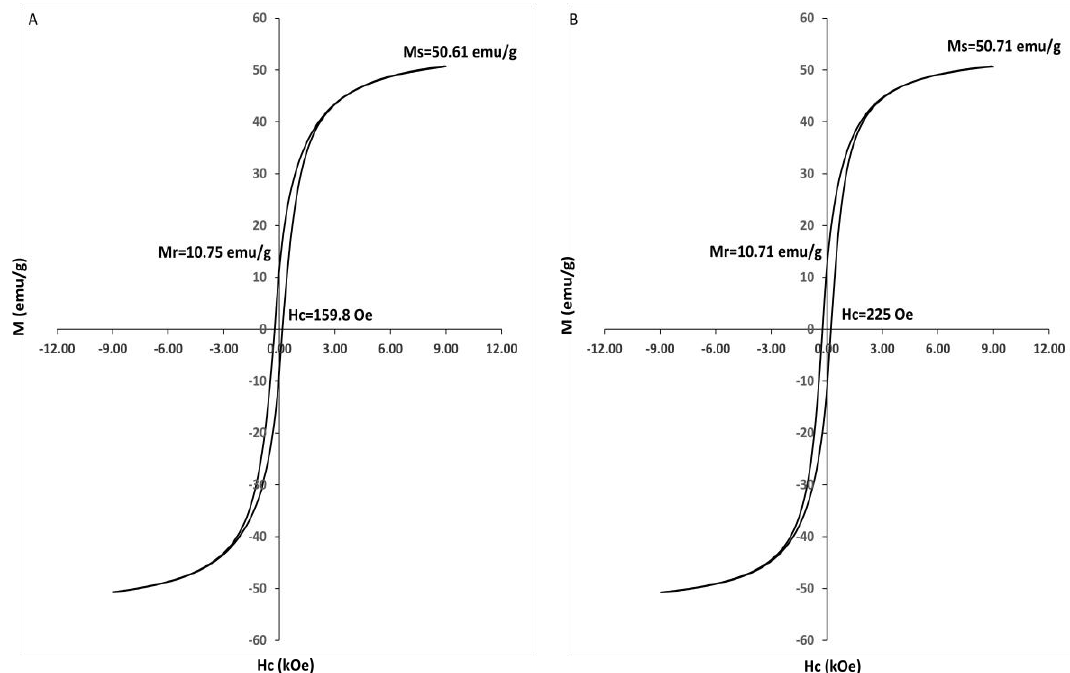
Figure 6. Hysteresis loops of CF-MNPs ( A ) and ZCF-MNPs ( B ).